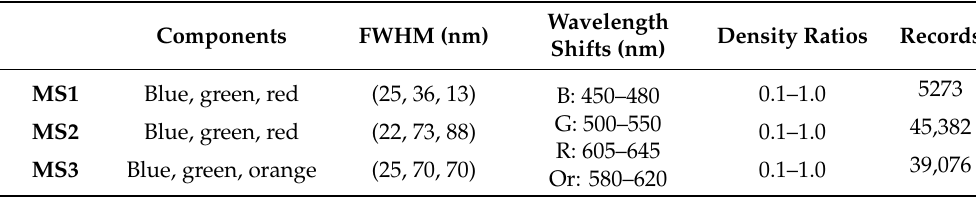
Table 1. Spectral parameters for